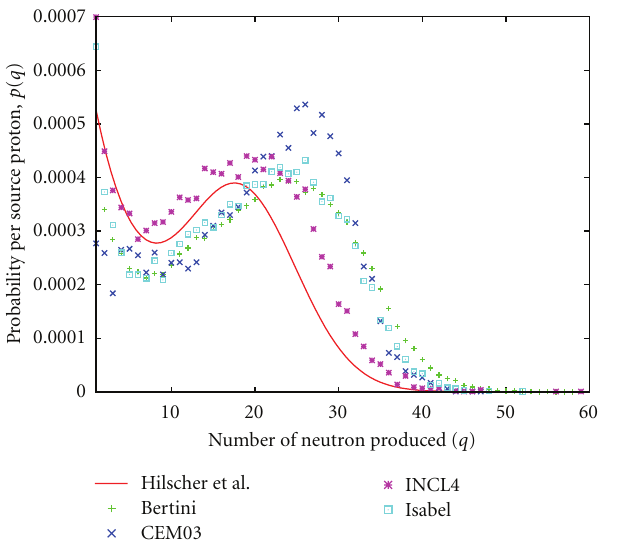
Figure 5: Comparison of measured and simulated distribution of the number of neutrons produced by a source proton for the 35cm thick